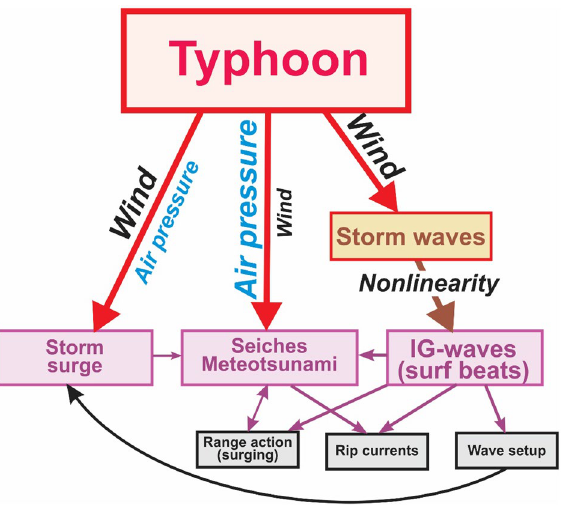
Figure 6. A sketch showing the various types of hazardous sea level oscillations and related phenomena generated by a